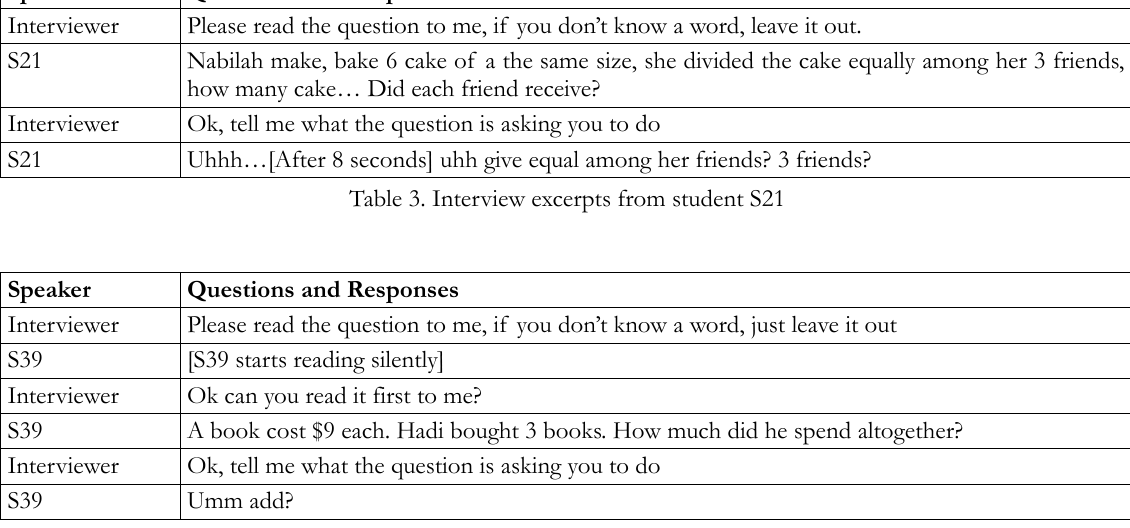
Table 4. Interview excerpts from student